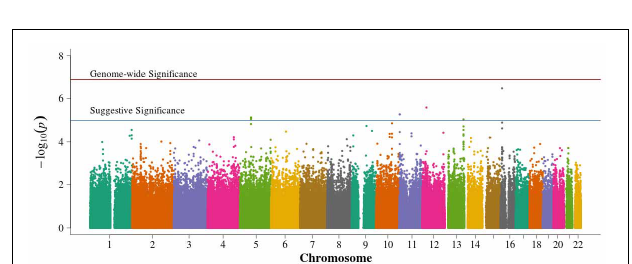
FIGURE 6 | Manhattan plot for METAL. Summary of genome-wide association scan results in the GoKinD collection of the meta-analyzed population-based and family-based P-values. The − log 10 P -values were calculated for SNP association with diabetic nephropathy among subjects with type 1 diabetes by combining each study P -value using the METAL sample size method. The red horizontal line corresponds to genome-wide significance ( P -value = 0 . 05 / 385 , 830 = 1 . 3 × 10 − 7 ). The blue horizontal line corresponds to suggestive significance ( P -value = 1 × 10 − 5 ).